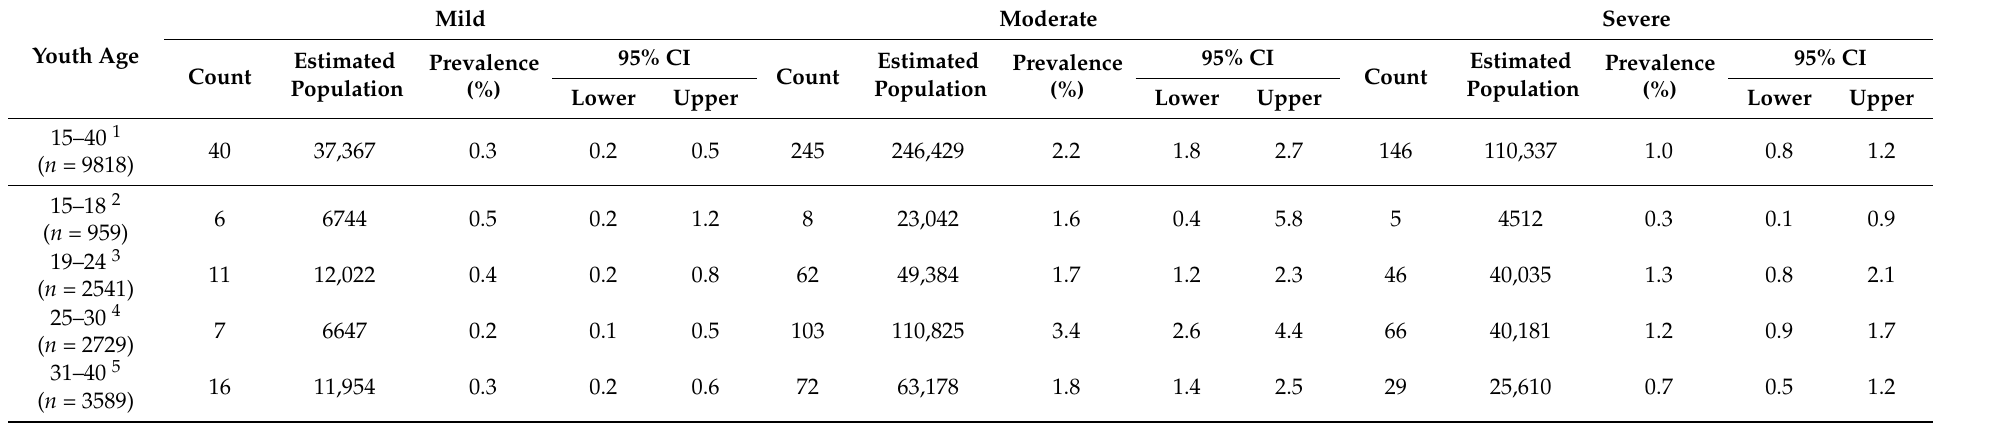
Table 6. Comparison of prevalence rates by severity according to age group ( n =